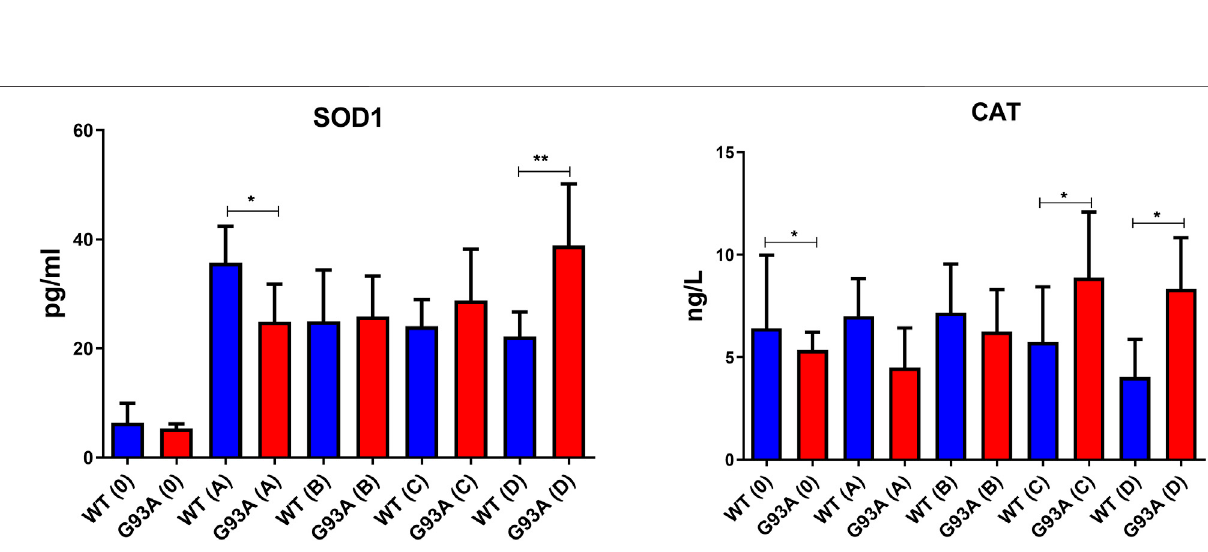
Frontiers in Bioengineering and Biotechnology |